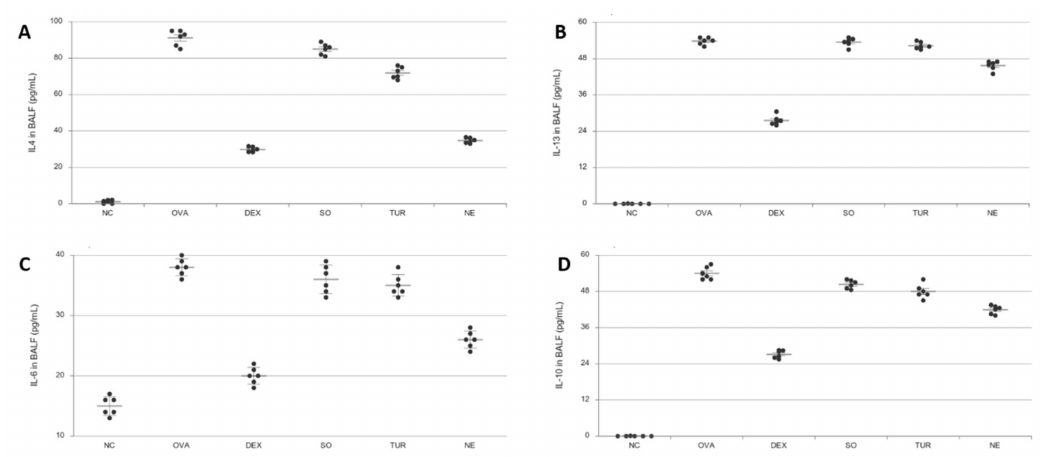
Figure 7. E ff ect of oral administration of dexamethasone (DEX), vehicle (SO), turmeric (TUR), and nano-emulsion on the levels of ( A ) IL-4 (pg / mL), ( B ) IL-6 (ng / mL), ( C ) IL-13 (pg / mL), and ( D ) IL-10 in the BALF of OVA-sensitized mice (i.p. 1st and 10th day) and challenged (inhalation, from day 19th to 24th). The results were expressed as Mean ± SEM ( n = 6). One-way ANOVA was followed by Student–Newman–Keuls test. DEX and NE have p < 0.001, TER has p < 0.01, SO has p < 0.05 compared with disease control (OVA), and OVA has p < 0.001 compared with NC.